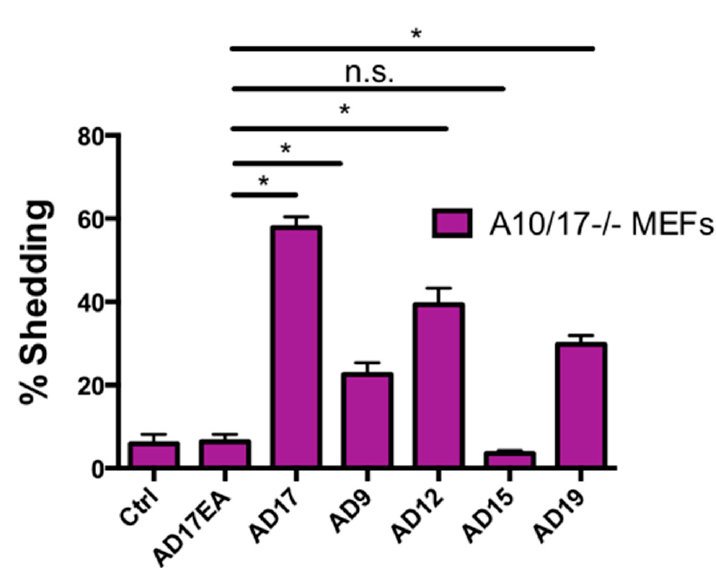
Figure 7. ADAMs 9, 12, and 19 can cleave N1-AP in A10/17-/- mEFs. Overexpression of ADAMs 9, 12, 15, 17, and 19 in A10/17-/- mEFs shows that all but ADAM15 can increase the processing of N1-AP compared to the catalytically inactive ADAM17E>A control. Data are shown as mean ± SEM for n ≥ 3 independent experiments ( n = 3 for ADAM17E>A mutant, n = 6 for all other samples). * indicates p < 0.05 using the unpaired 2-tailed Student’s t -test. The difference between the control sample, in which only N1-AP was expressed, and the sample in which the inactive ADAM17E>A was co-expressed with N1-AP was not statistically significant (not indicated on the figure), and the difference between N1-AP shedding in the presence of overexpressed inactive ADAM17E>A and ADAM15 also did not reach statistical significance (n.s.).